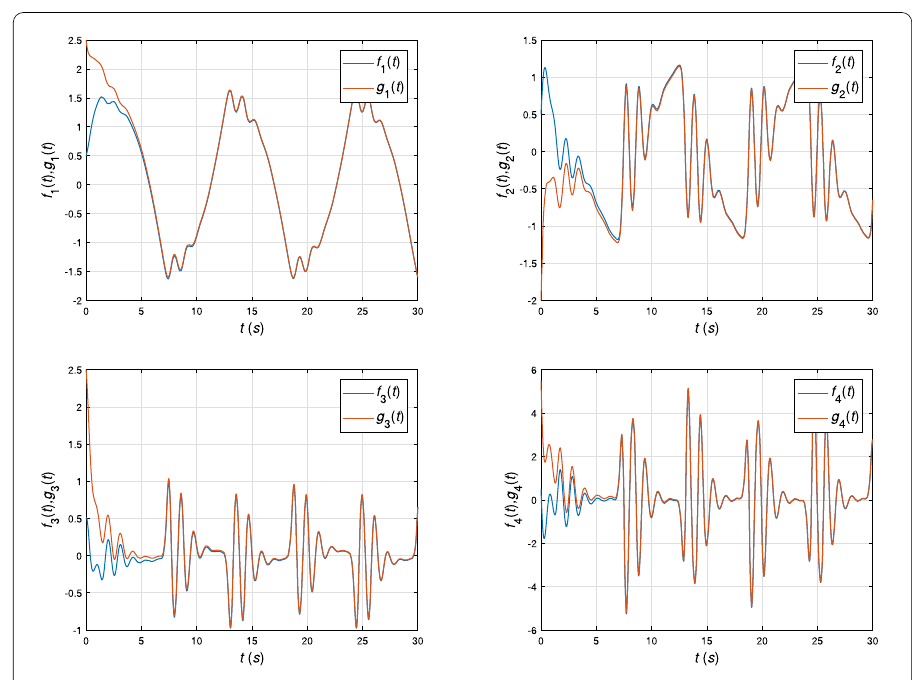
Figure 15 The state trajectories of the synchronized systems (19) and (20) for q = 0.94